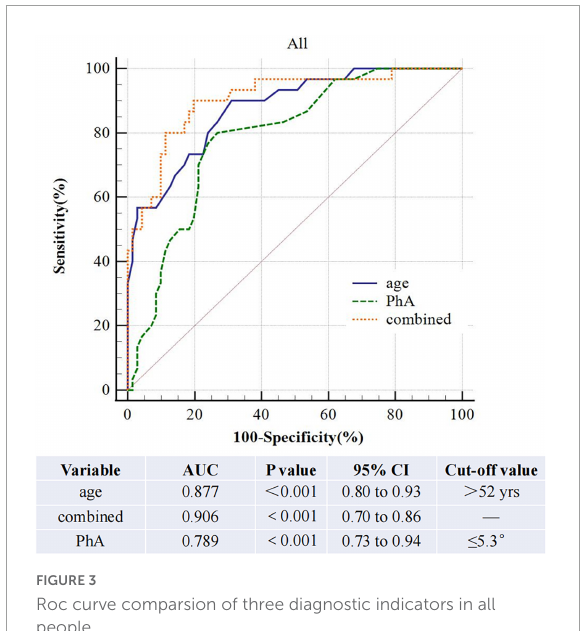
FIGURE3 Roc curve comparsion of three diagnostic indicators in all people.